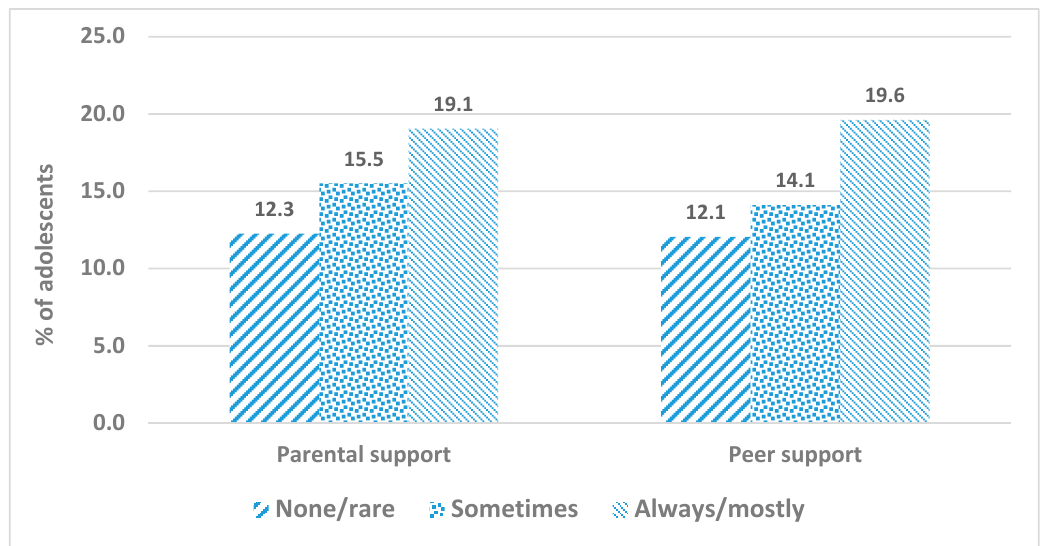
Figure 1. Prevalence of adolescents’ sufficient physical activity by levels of parental and peer support using the Global School-based Student Health Survey, 2007–2016.